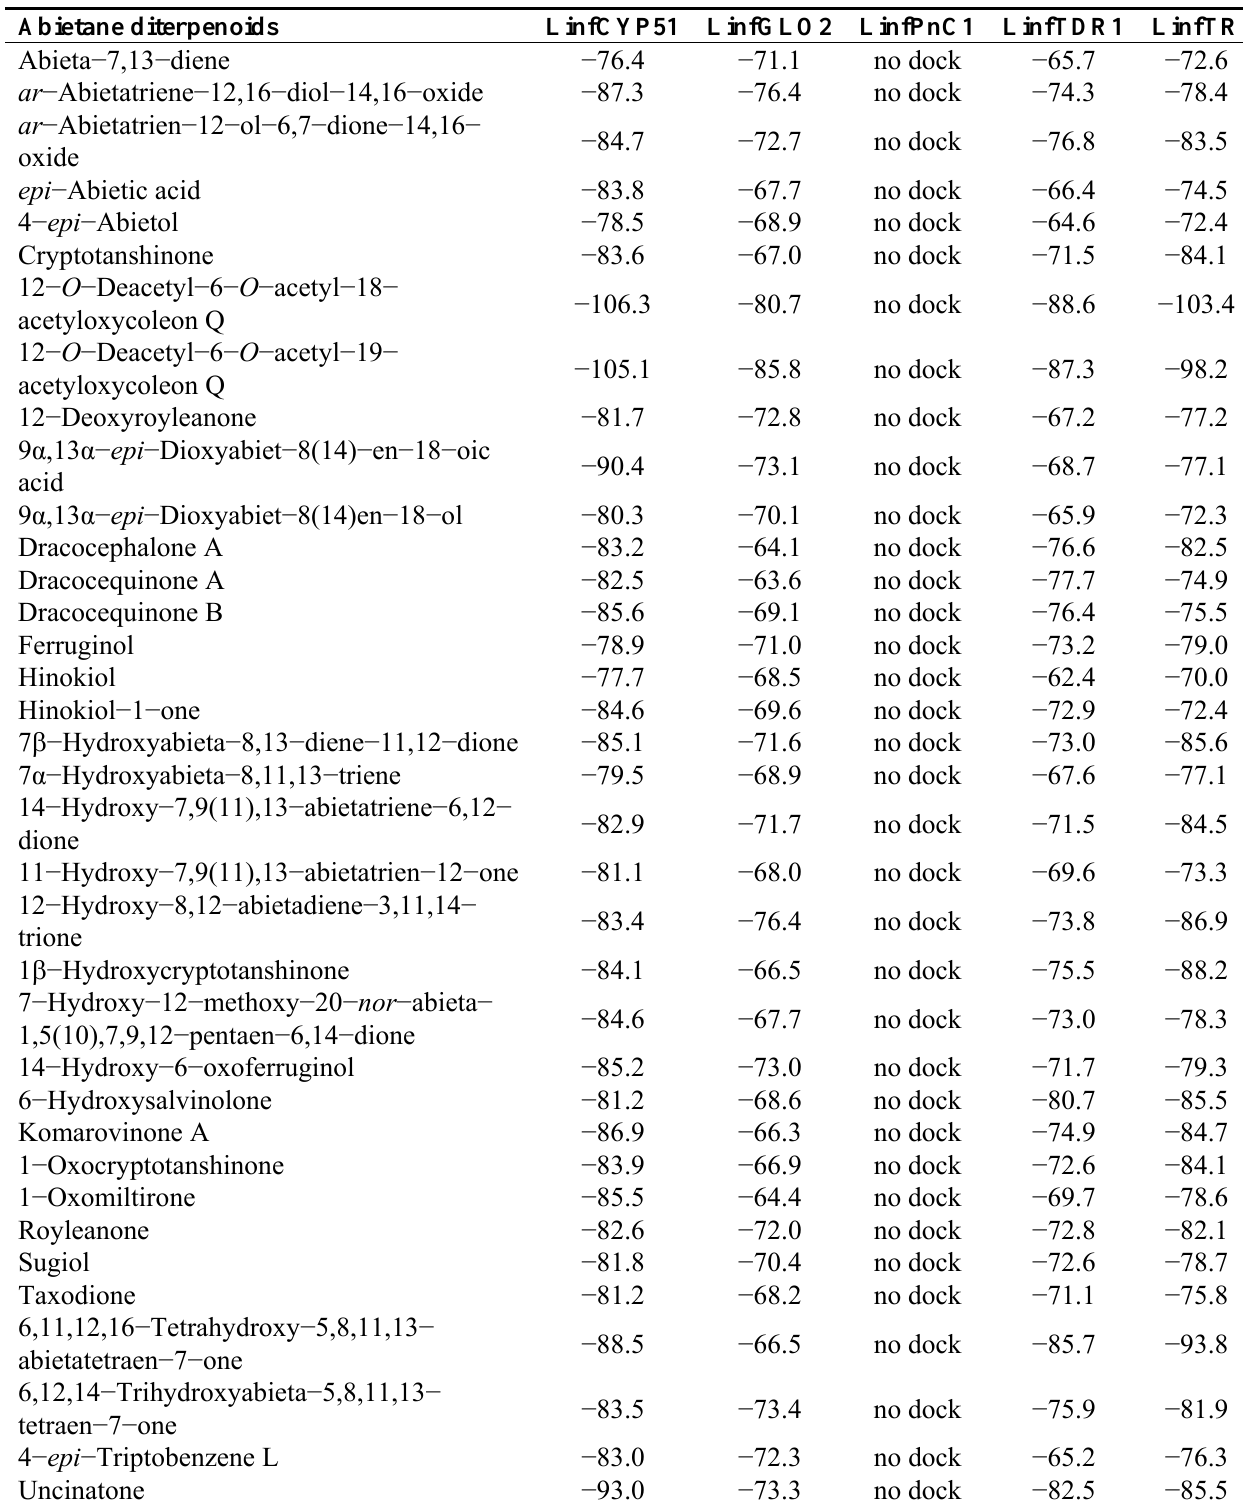
Table 18. MolDock docking energies (kJ/mol) of abietane diterpenoids with Leishmania infantum protein